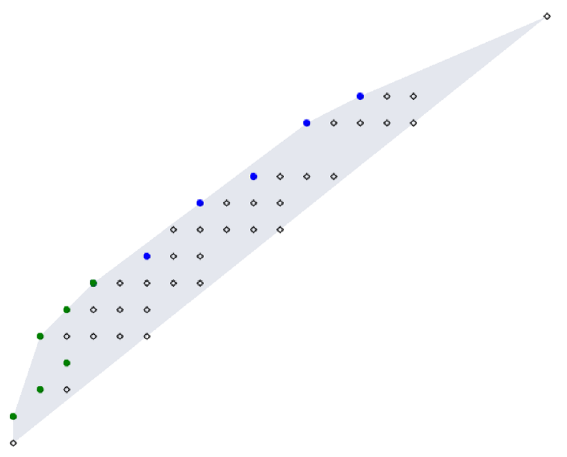
Figure 22 . Newton polygon for diag(2 ; 2 ; 4)